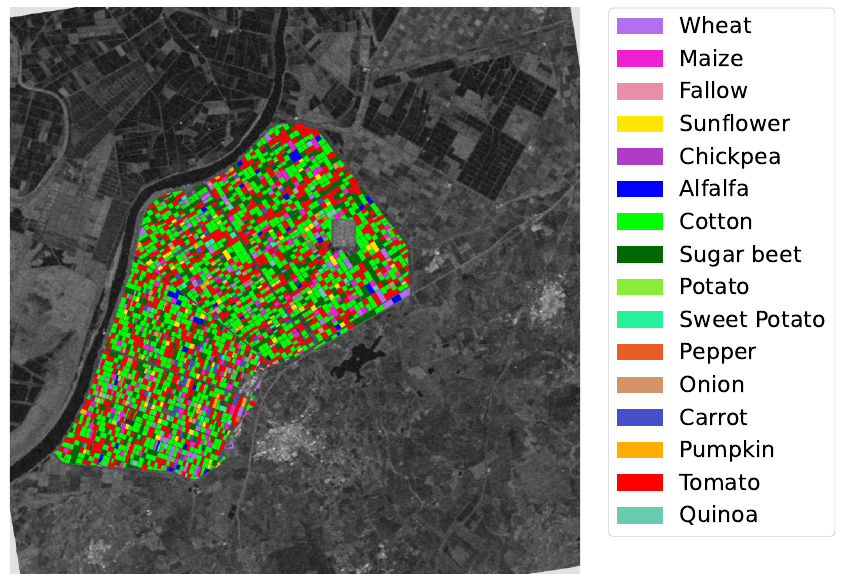
Figure 1. Illustration of the BXII Sector (36°59 N 6°06 W) and reference crop types data over a Sentinel 1 σ 0 VH polarization image acquired in orbit 74 on the 3rd of January